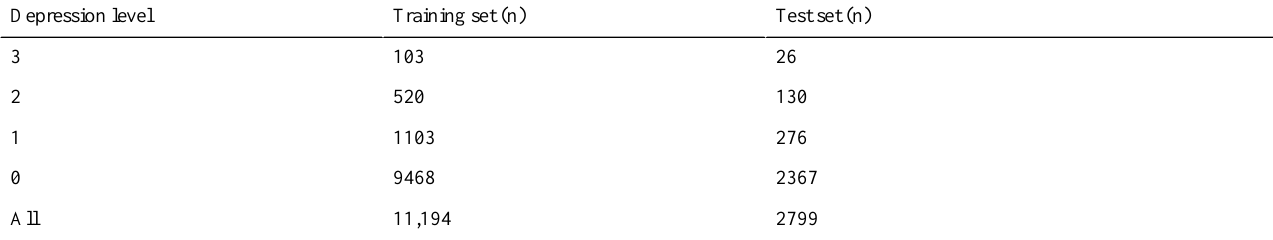
Table 2. Dataset